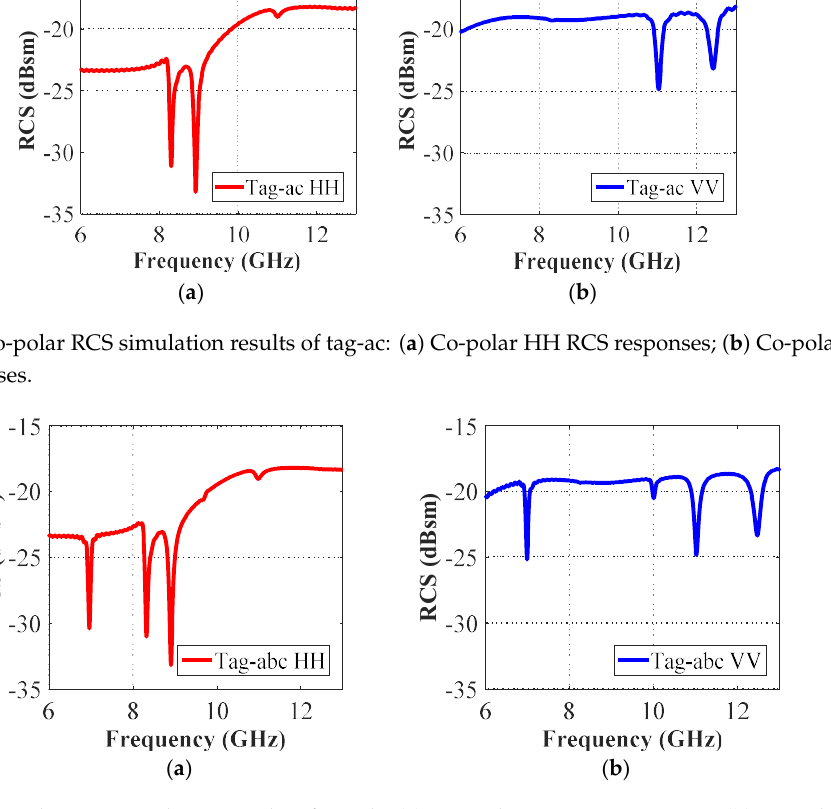
( b ) Figure 9. Co-polar RCS simulation results of tag-abc with and without the ground plane under the tag structure ( a ): Co-polar HH RCS responses; ( b ) Co-polar VV RCS responses. The effect of the change in the resonance properties of the letter-tag with the variations in its position and its repetition is illustrated in Figure 10, which shows that the location modification or the repetition of the letters reproduce a maximum shift of 0.009 GHz which is approximately 0.1% of the total utilized spectrum bandwidth. It is a negligible variation and it has no effect on the unique electromagnetic signature of the letter-tags. The change of the location or repetition of the letter-tags varies the magnitude of resonance dips with minimum change in their unique resonance characteristics. ( a ) ( b ) Figure 10. Cross-polar HH RCS simulation results ( a ) Letter place change effect; ( b ) Letter repetition effect.